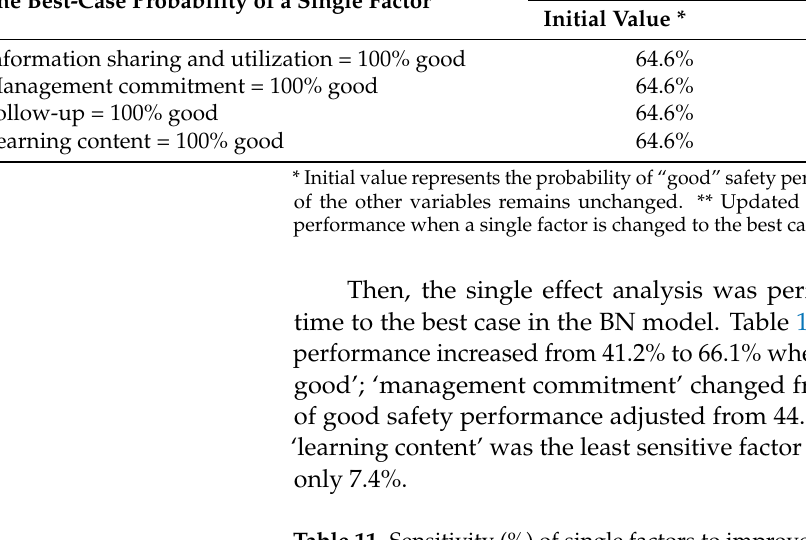
Table 11. Sensitivity (%) of single factors to improve safety performance.